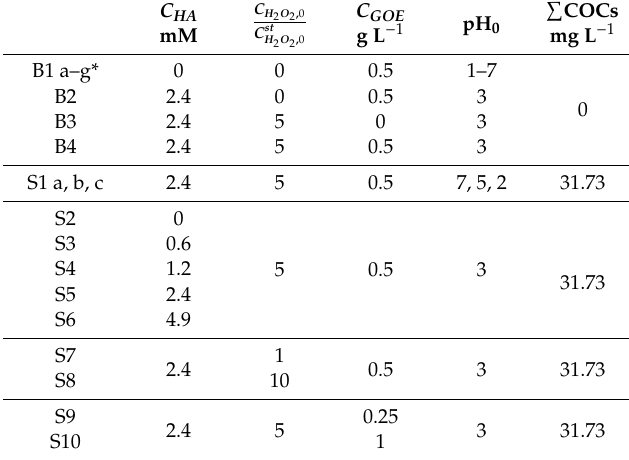
Table 1. Experimental conditions of the runs carried out. Variables: initial concentration of hydroxylamine ( C HA ), theoretical stoichiometric amount of hydrogen peroxide for the complete mineralization of the chlorobenzenes (nCBs; n = mono, di, tri, tetra). ( C H concentration ( C GOE ), pH using either milliQ or spiked water with chlorinated organic compounds